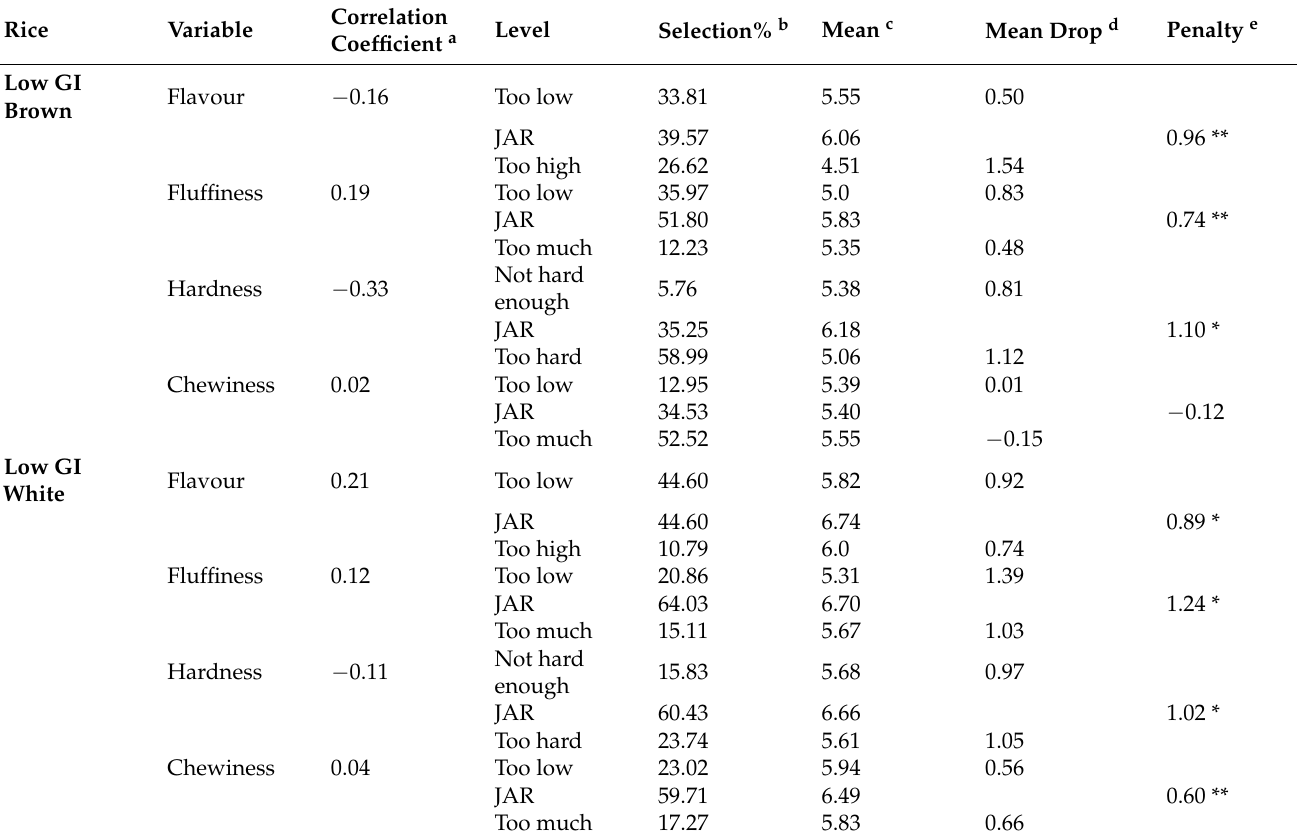
Table 9. The Penalty analysis and JAR variables (after tasting) for Low GI brown and Low GI white